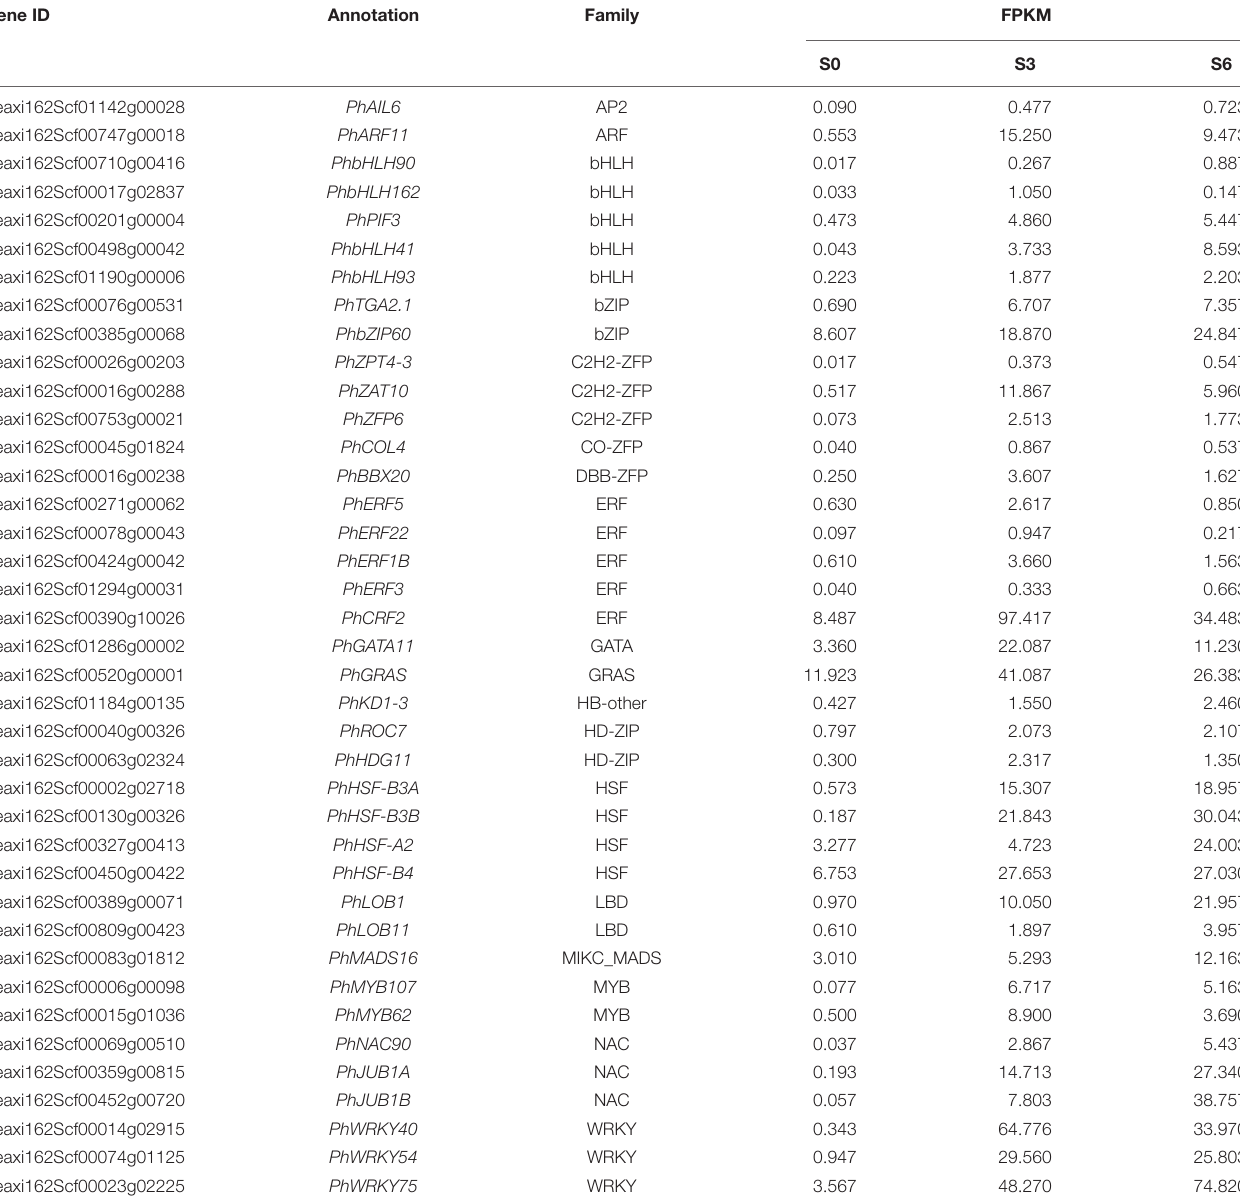
TABLE 2 | Selected candidate transcription factors used for screening antiviral RNA silencing-related genes. Gene ID